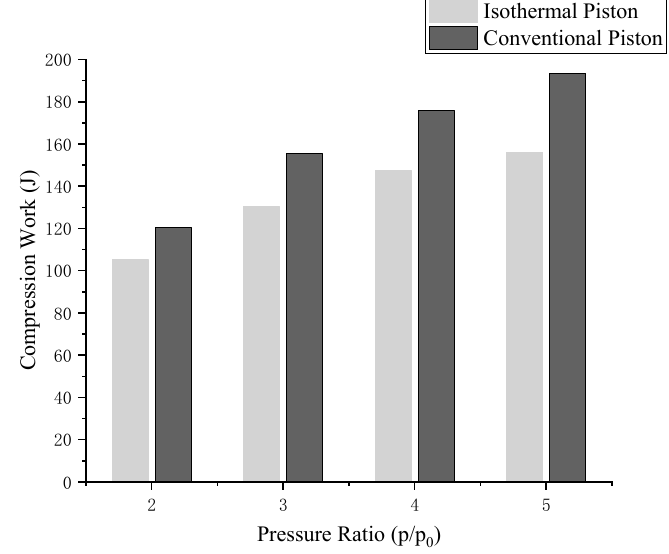
Figure 12. Compression work (not including work to overcome frictional forces).